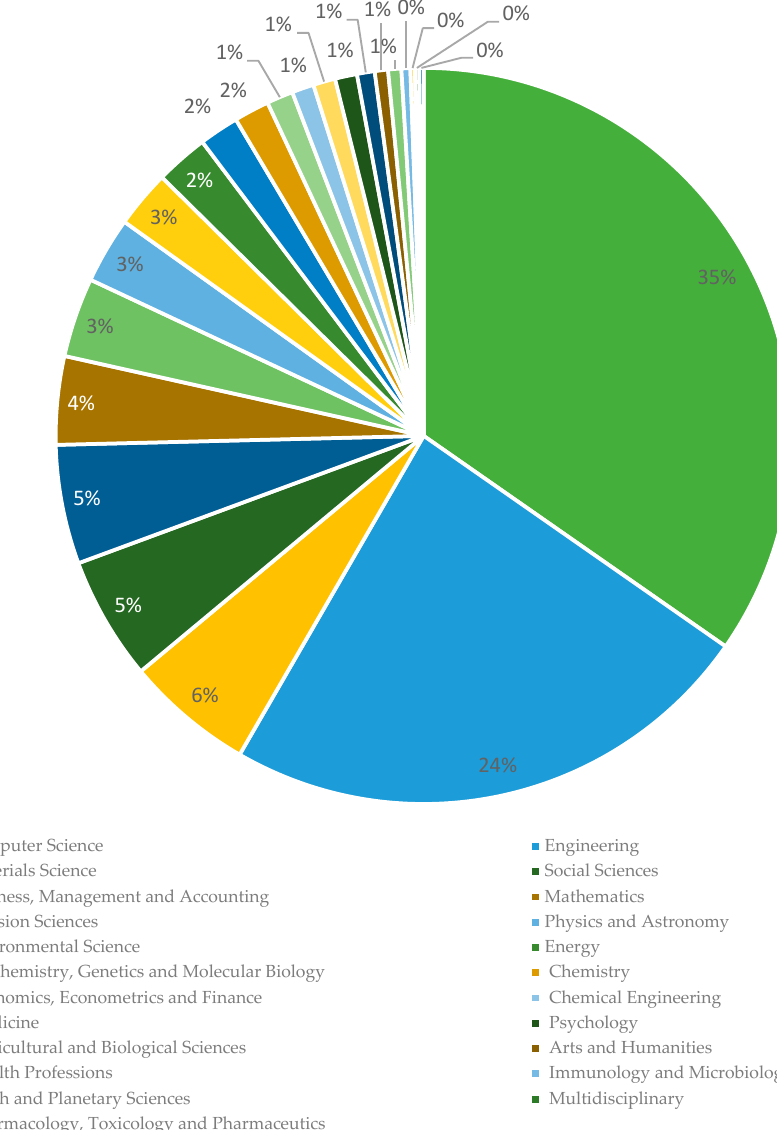
Figure 1. The number of articles on the topic published between 2012 and 2022.